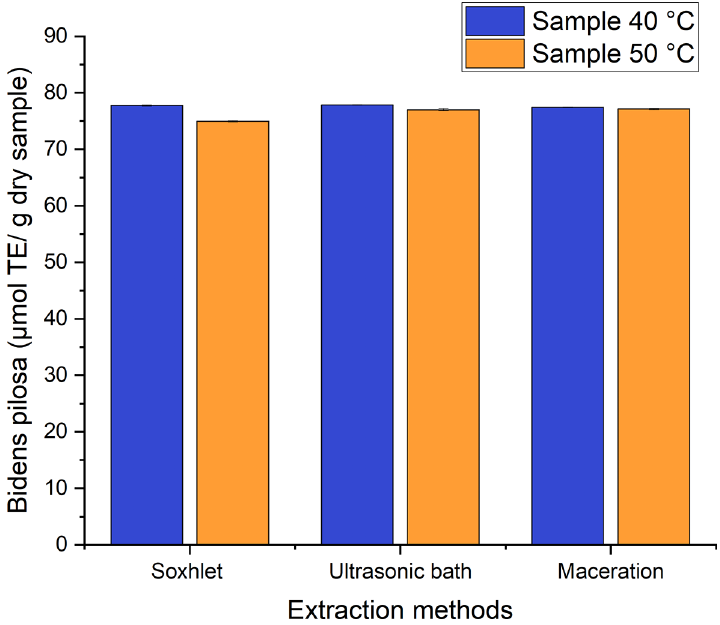
Figure 13. Antioxidant activity equivalent to Trolox of the different extracts of Bidens pilosa L.